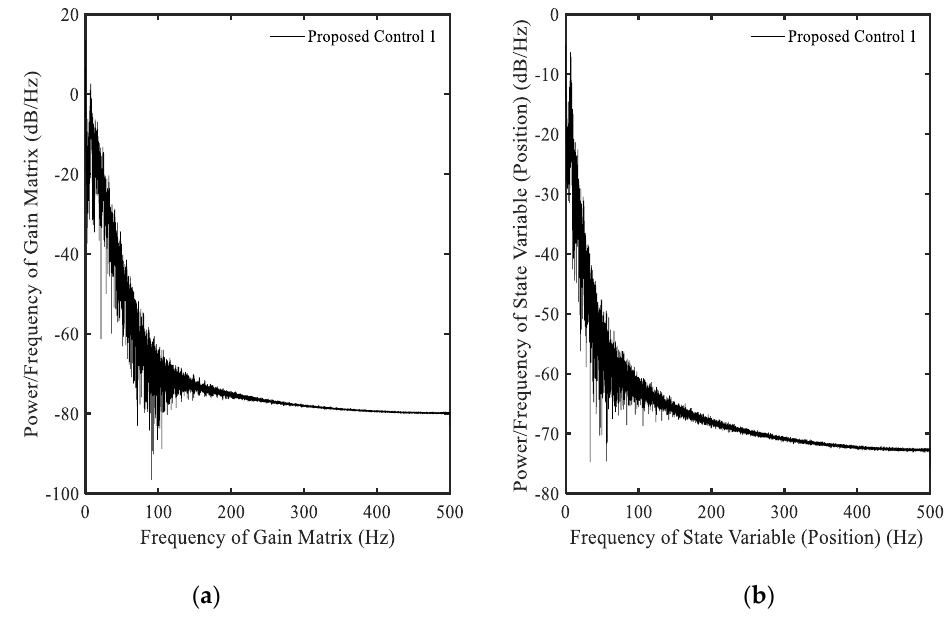
Figure 3. Power Spectral Density (PSD) of the proposed control 1 with Equation (12): ( a ) gain function Q ∆ L ( t ) , ( b ) state variable x e ( t ) .